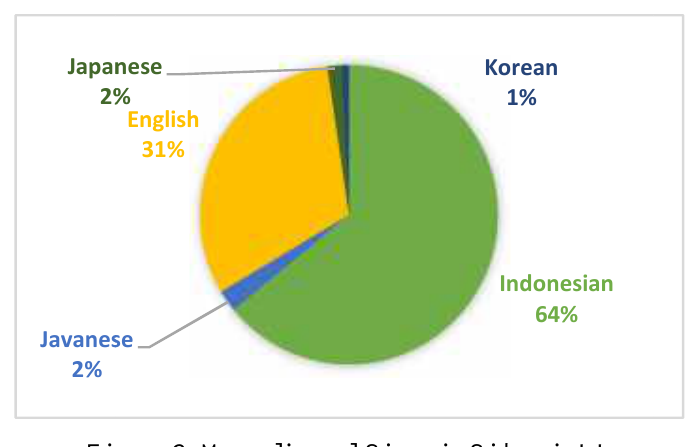
Figure 2. Monolingual Signs in Sidoarjo LL